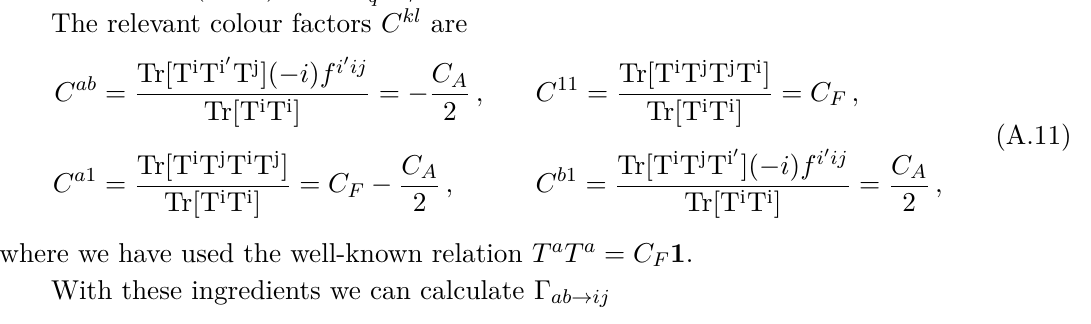
simplifies to 1